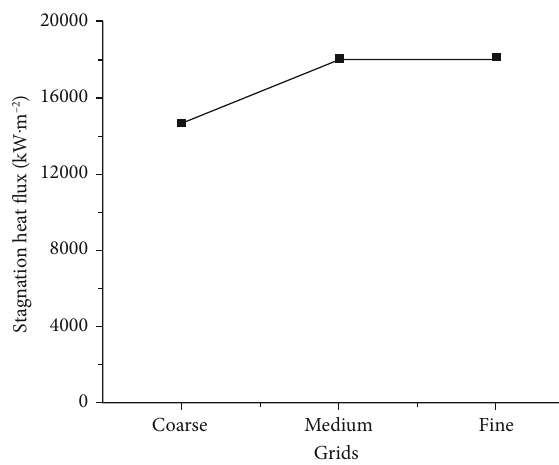
Figure 11: Stagnation heat fl uxes with di ff erent grids.